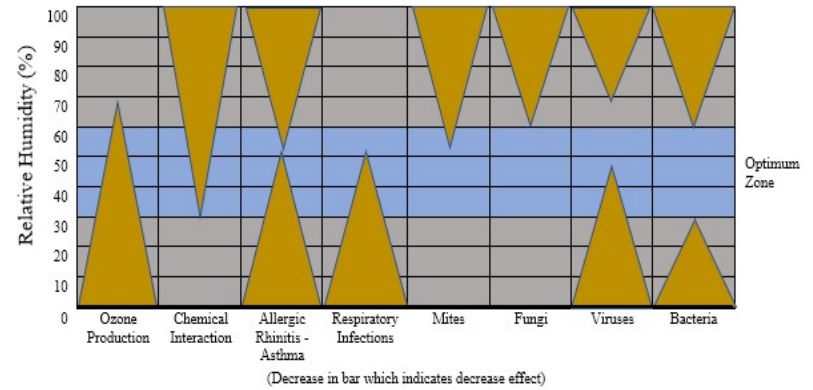
Figure 2. Humidity comfort level from a health aspect